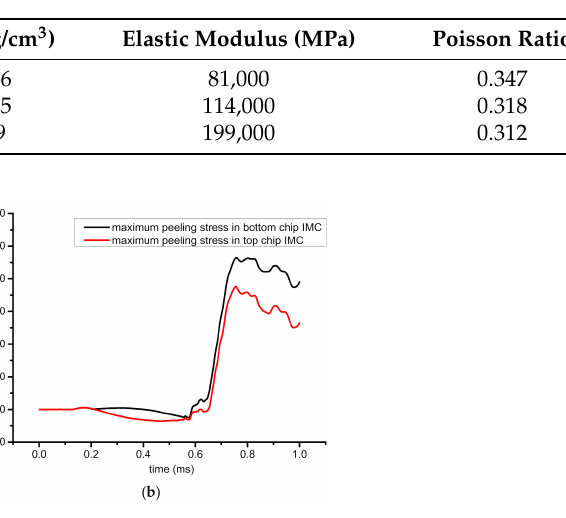
Table 1. Material properties of the main parts modeled as linearly elastic [14].